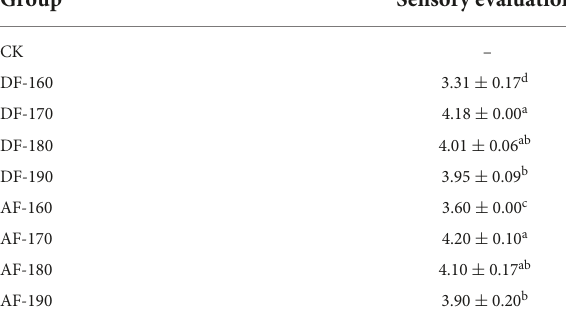
TABLE 6 Effect of frying method and temperature on sensory scores of shrimp